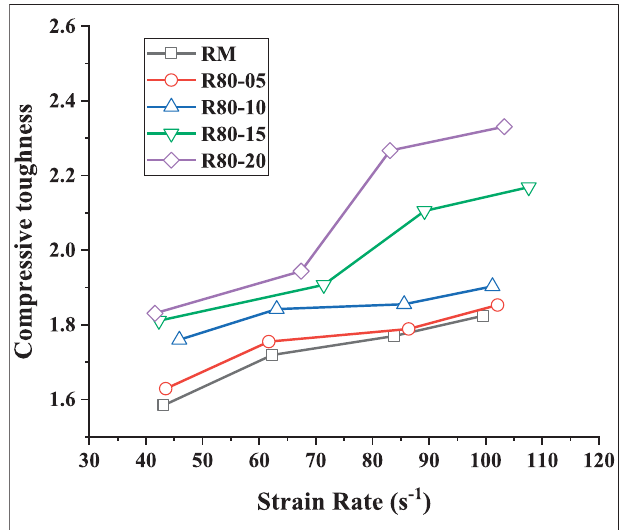
FIGURE 19 | Compressive toughness of mortar with different rubber contents under dynamic impact.